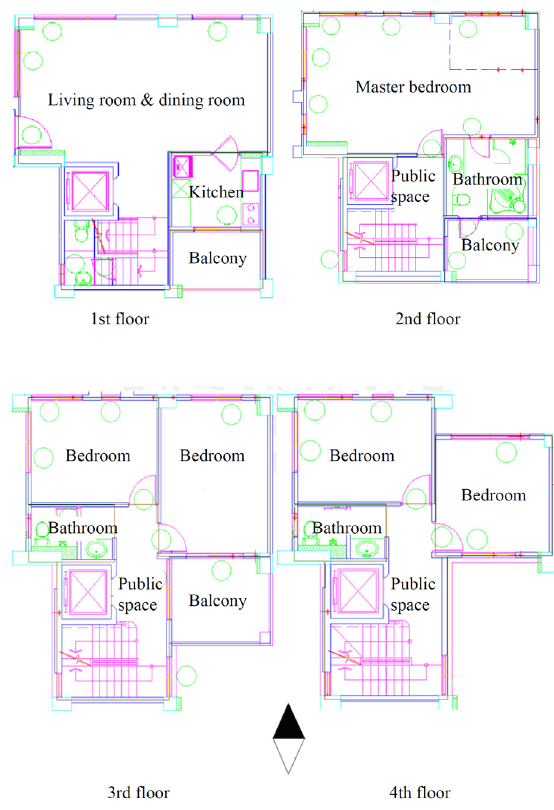
Figure 2. Floor plans of the main simulation target (not to scale).